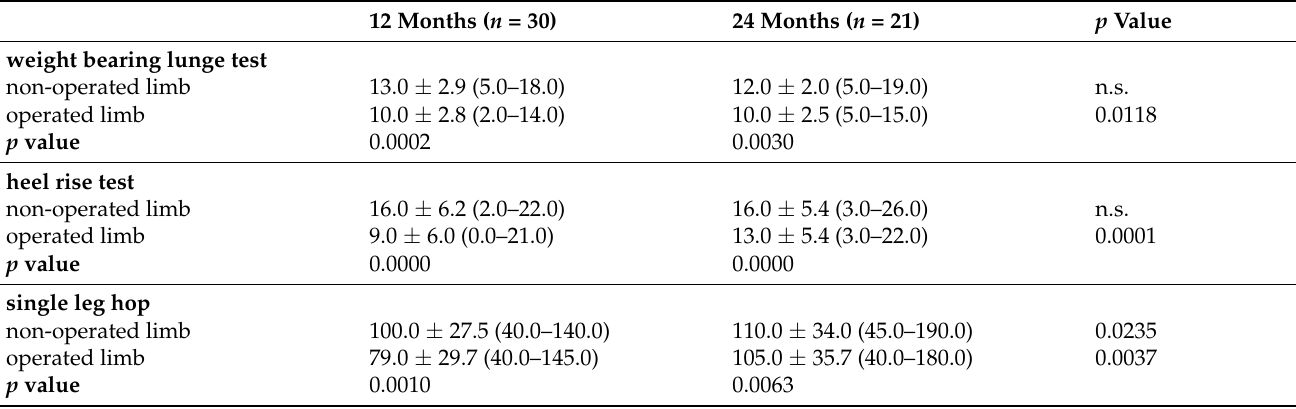
Table 4. The functional outcomes of the surgical